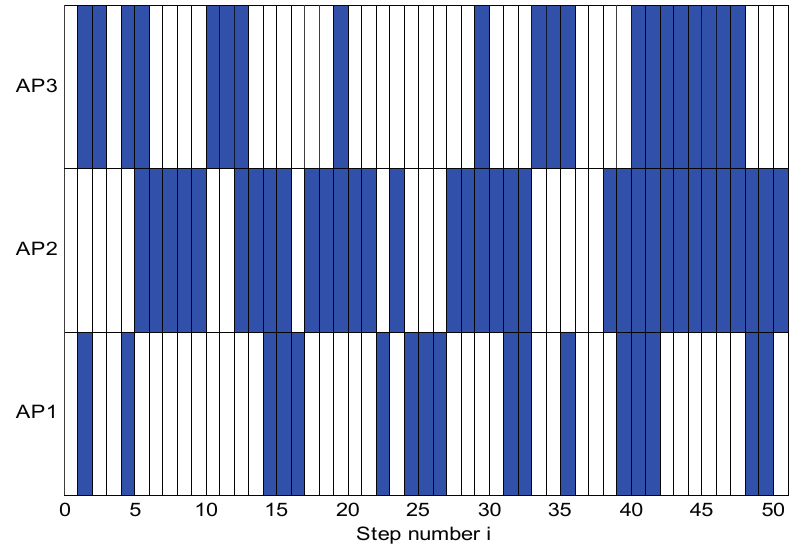
Figure 13. LOS/NLOS